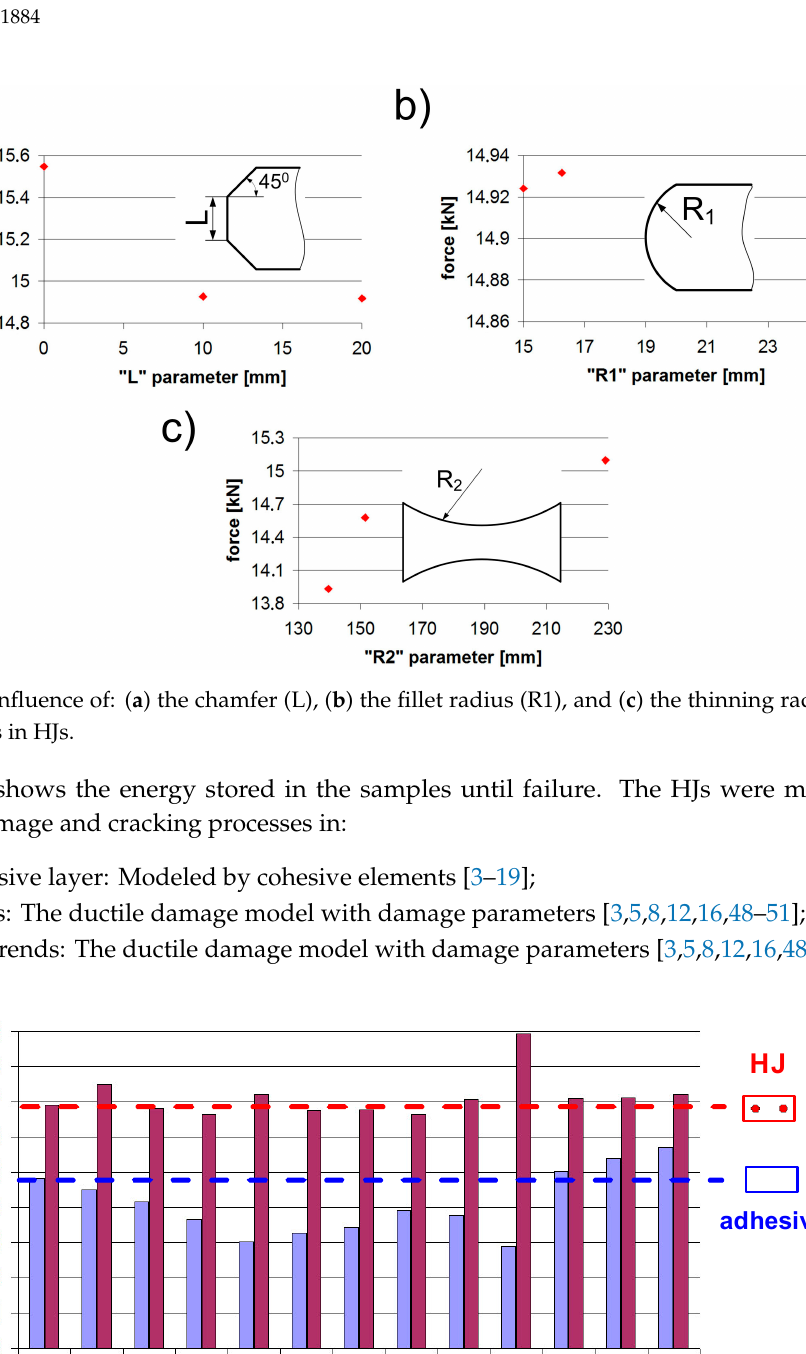
Figure 8. Energy in pure adhesive and hybrid joints.